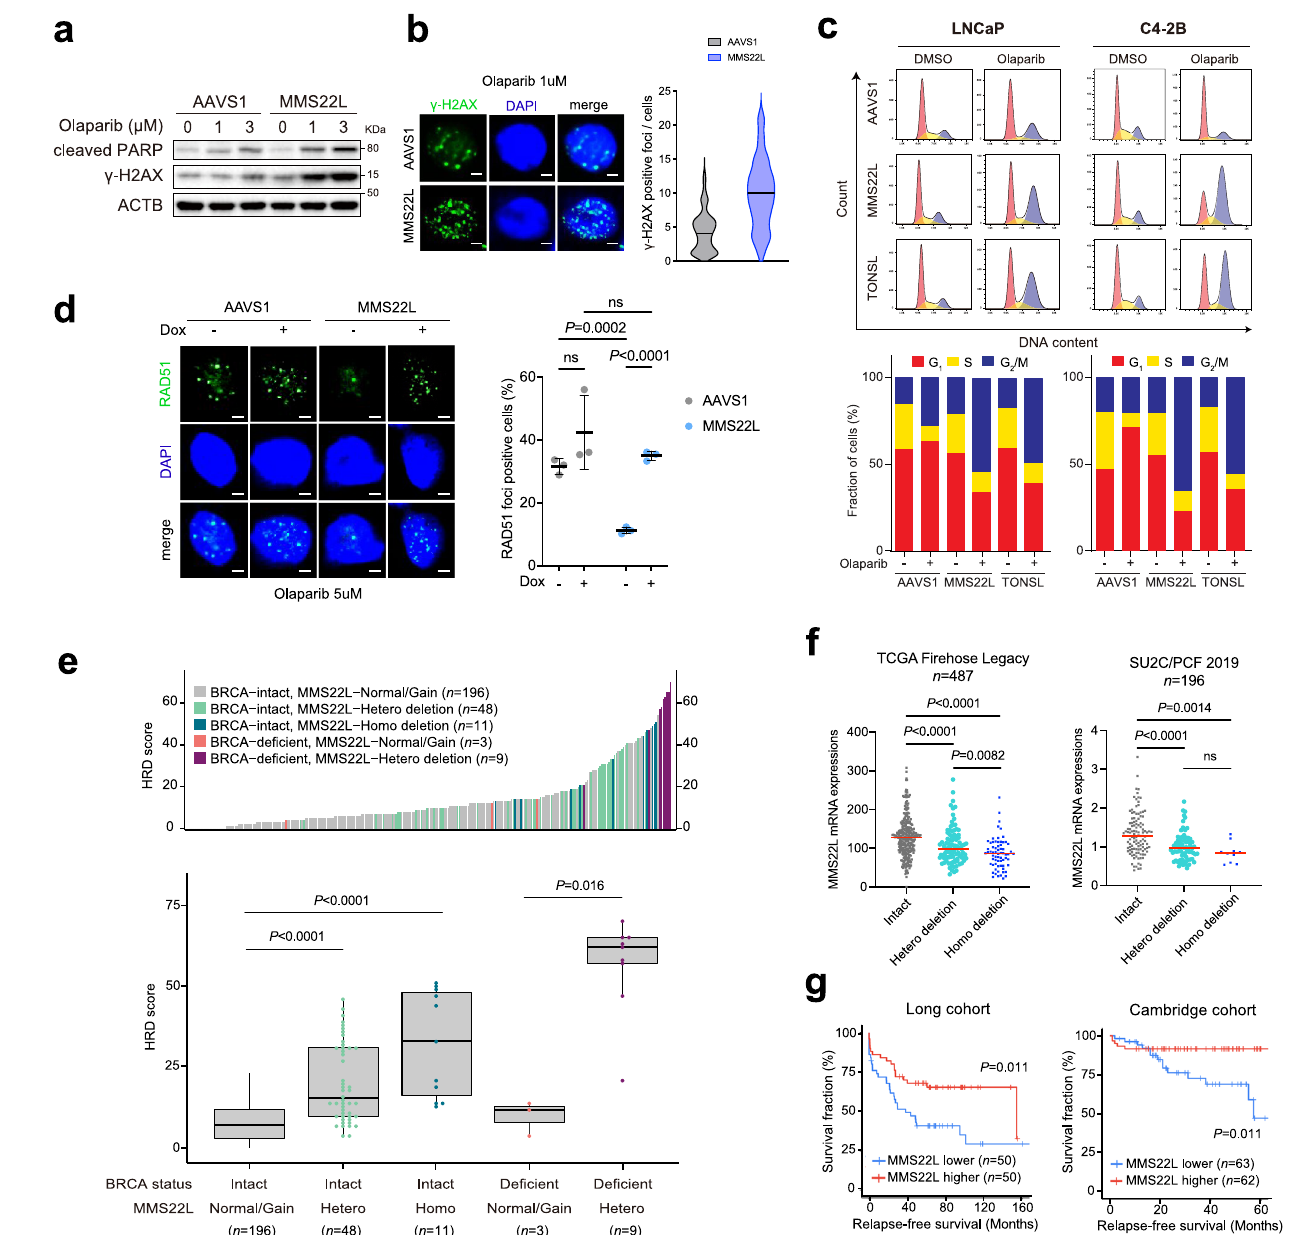
Fig.4|Lossof MMS22L impairsHRRfunctioninPCacells.a Immunoblotanalysis of cleaved PARP and γ -H2AX in AAVS1 control and MMS22L -KO C4-2B cells after olaparib treatment for 72h. The experiment was repeated independently three timeswithsimilarresults. b Representativeimagesoftwobiologicallyindependent experiments and quanti fi cation of γ -H2AX foci in AAVS1 control and MMS22L -KO C4-2Bcellsafterolaparibtreatmentfor24h.Morethan100cellswereanalyzedper condition. Solid lines inside the violin indicate the median. Scale bar=5 μ m. c Cell cycle analysis (upper panel) of AAVS1 control, MMS22L -KO and TONSL -KO LNCaP, and C4-2B cells after treatment with DMSO or olaparib for 72h. The percentage of cells (lower panel) in each phase of the cell cycle is shown. The experiment was repeated independently twice with similar results. d Representative images and quanti fi cation of RAD51 foci in AAVS1 control and MMS22L -KO C4-2B cells stably infectedwith TET-inducible MMS22L gene after olaparibtreatment in the presence or absence of doxycycline (0.15 μ g/ml) for 24h. Dots indicate each replicate with morethan100cellsanalyzed.Dataarepresentedasmean±SDofthreebiologically